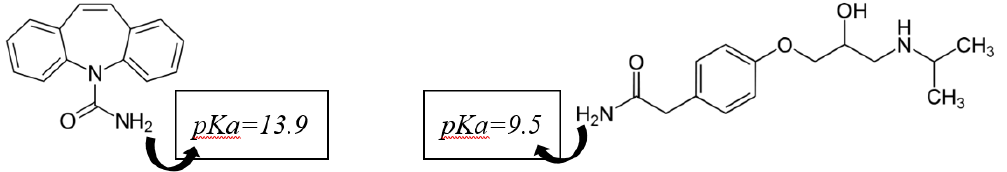
Figure 7. Kinetic of removal of 10 ppm of Carbamazepine and Atenolol at 20 °C by 20 mg of A -BBS0.4 in 10 mL of solution expressed in removal percentage. Table 5. q m of adsorption of Contaminants of Emerging Concern (CECs) by A -BBS0.4.